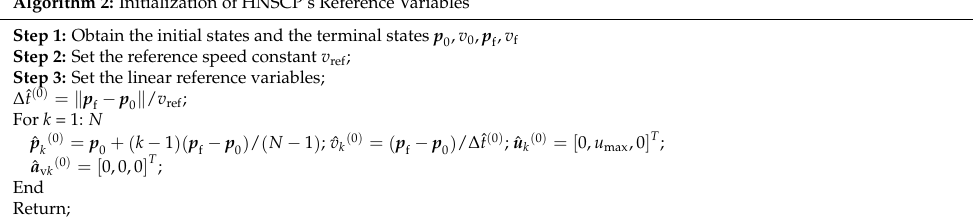
Algorithm 2: Initialization of HNSCP’s Reference